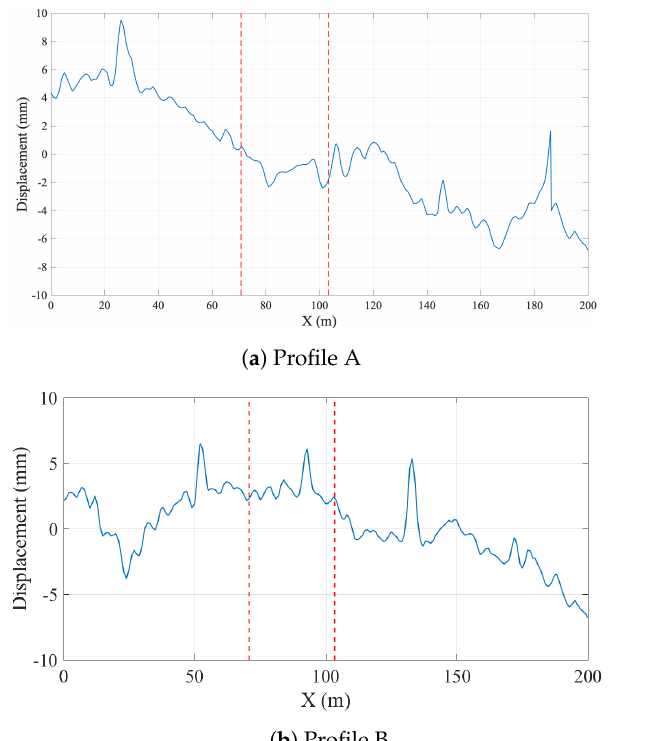
Figure 8. Track irregularity